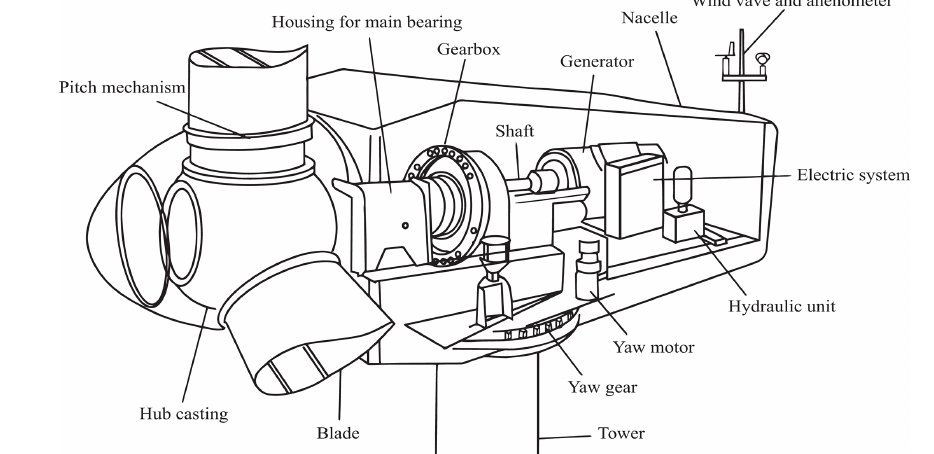
Figure 1. Main components of WTs (Jiang et al., 2017).